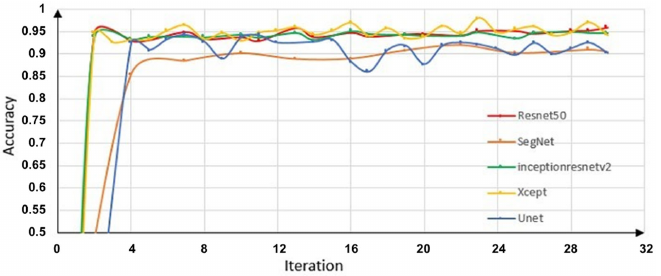
Figure 8. Comparison of the accuracy of the proposed network with that of other networks by number of iterations.